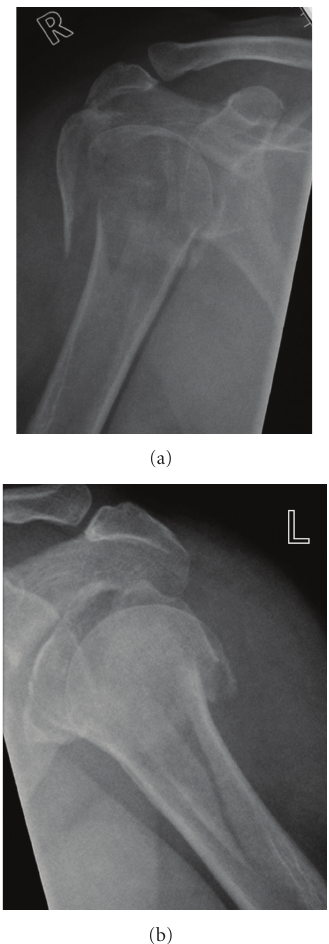
Figure 1: Preoperative radiographs demonstrating four-part prox- imal humeral fractures bilaterally.